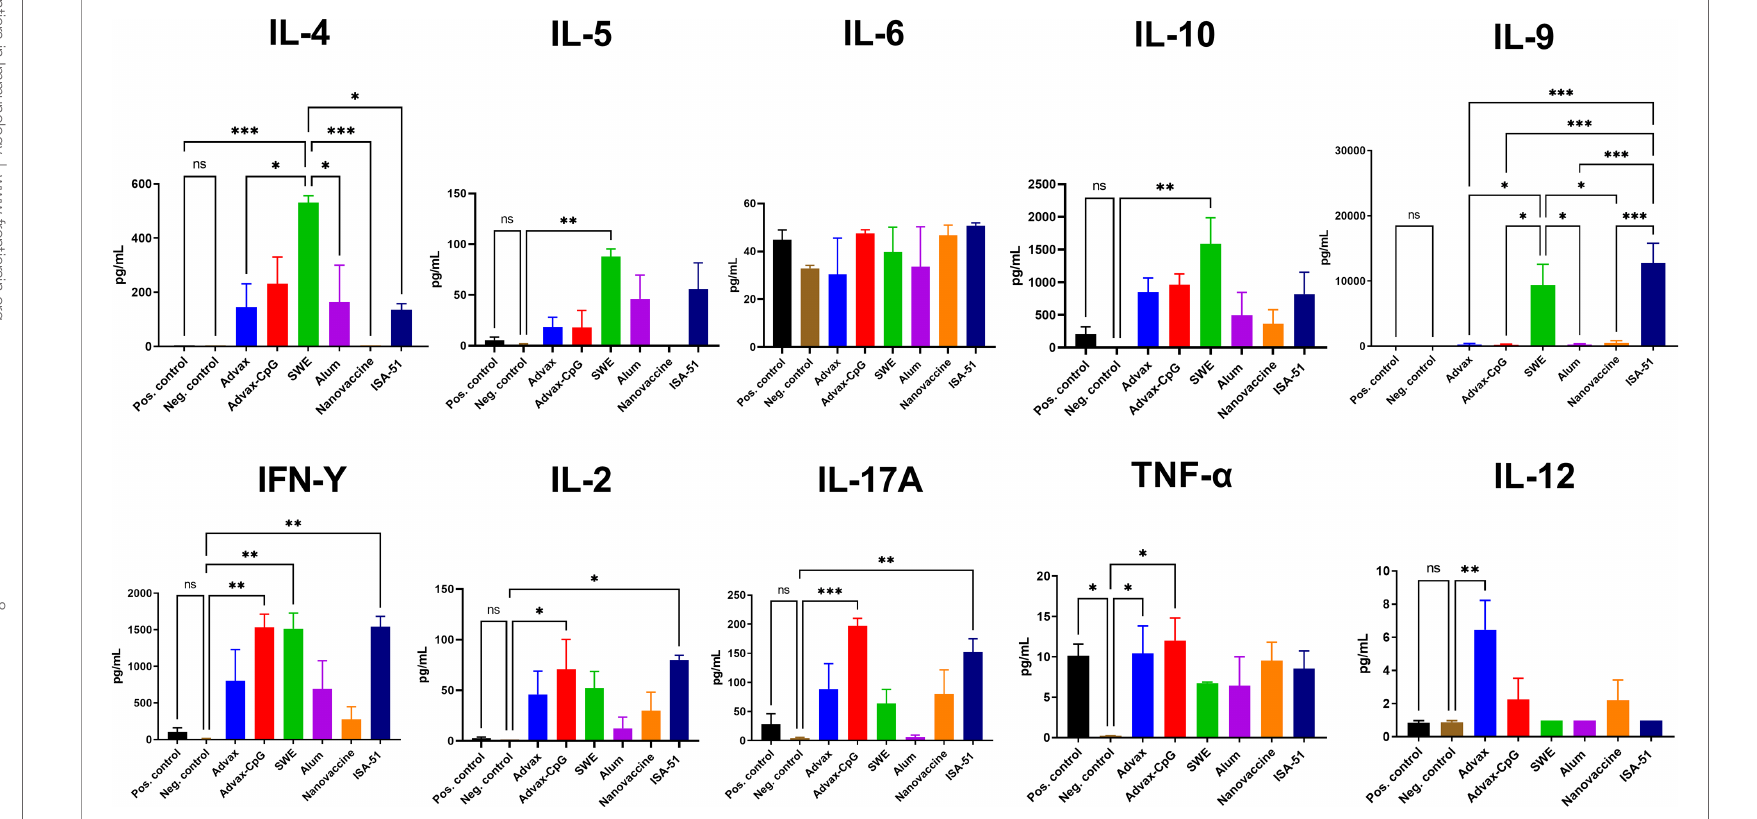
FIGURE 4 | Production of Th1, Th2, and Th17 cytokines in splenocyte suspensions after ASIT. Cytokine data are presented as the difference (delta) in cytokine concentrations between samples with or without stimulation with Art v 1. Differences between groups were assessed using Tukey ’ s multiple comparisons test. NS, Non signi fi cant. P < 0.05 value was considered a signi fi cant difference. *P < 0.05, **P < 0.01, ***P <